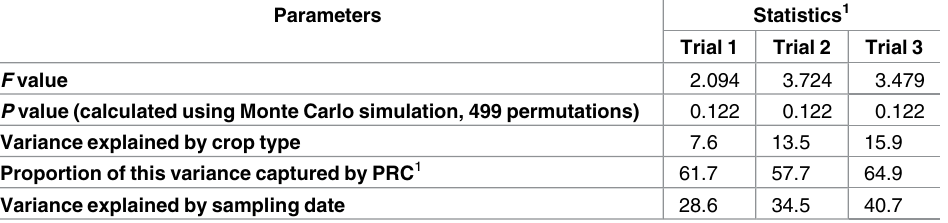
Table 3. Characteristics of Principal Response Curves (PRC) for non-target arthropod communities in Bt and non-Bt eggplants.